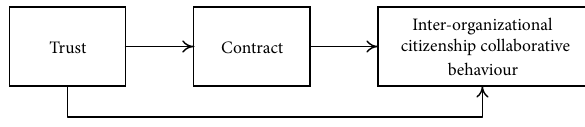
Figure 1. The theoretical